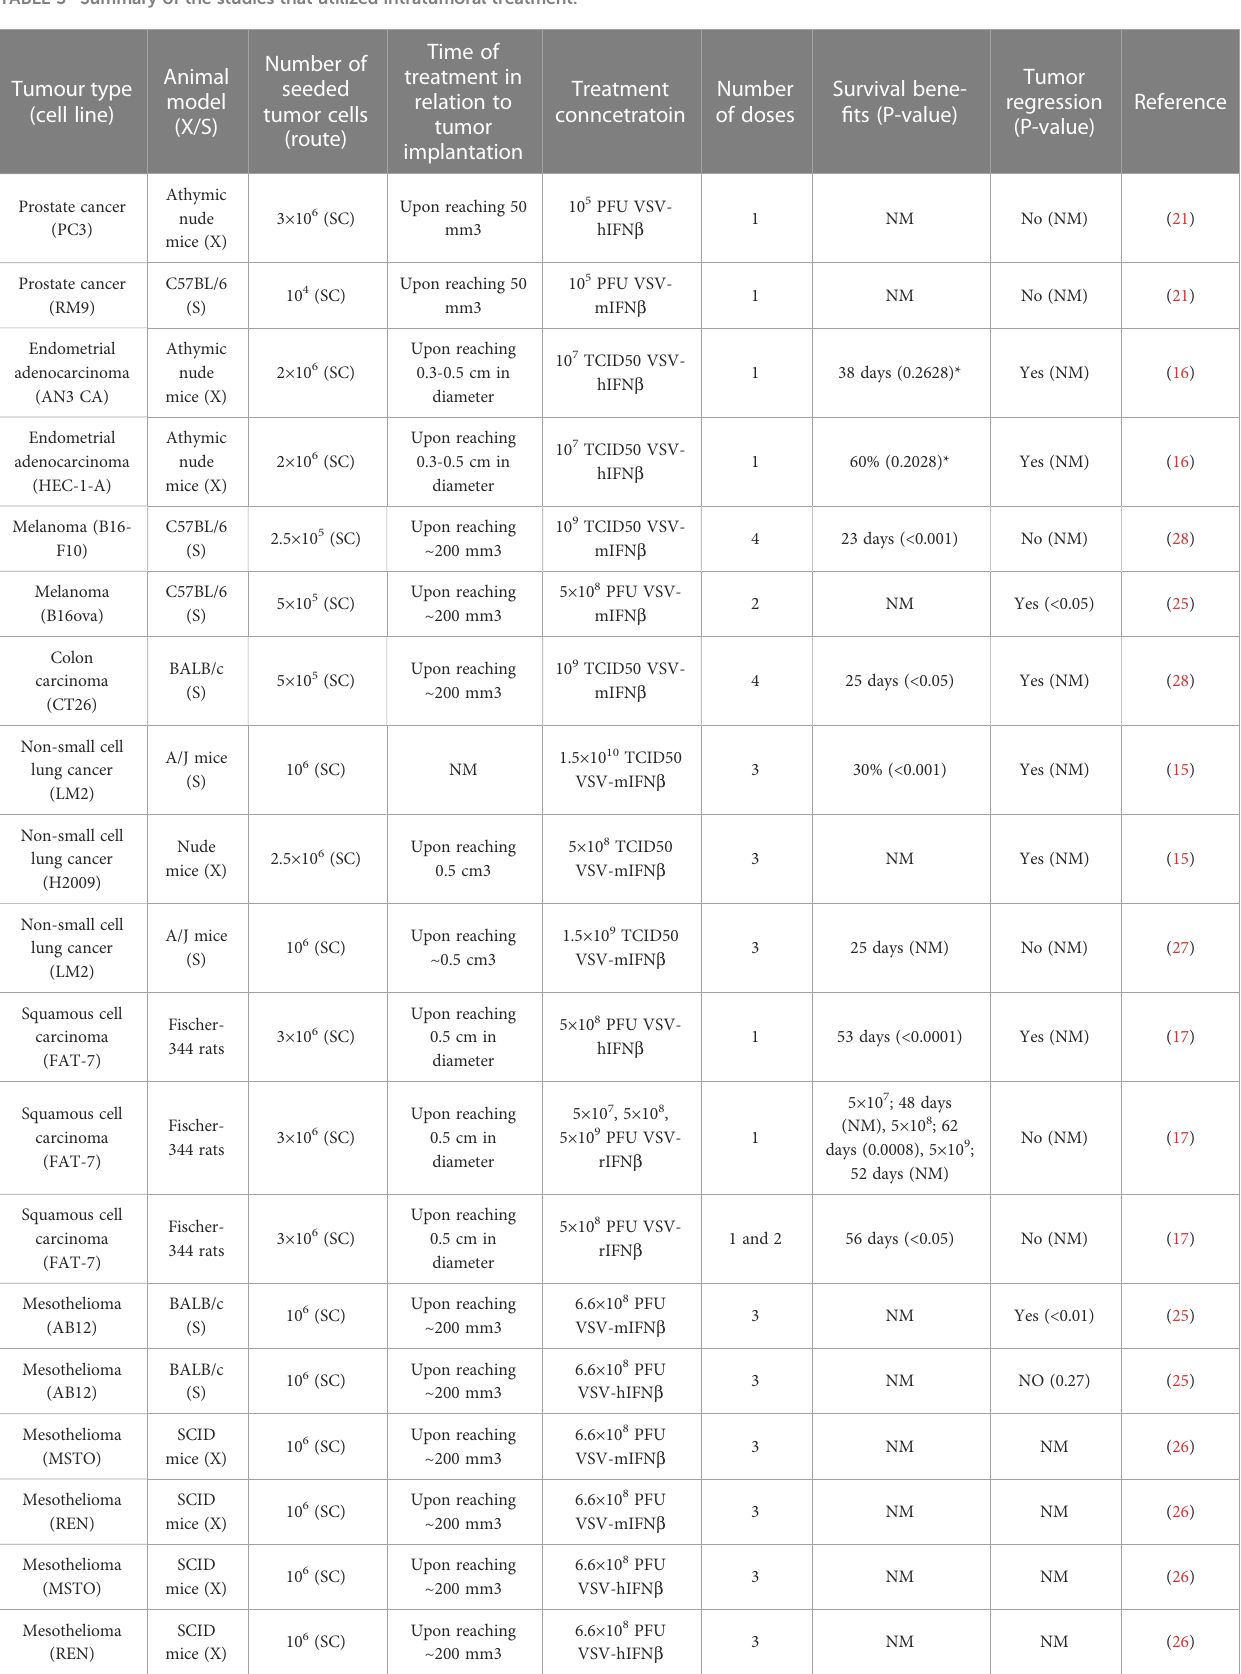
TABLE 3 Summary of the studies that utilized intratumoral